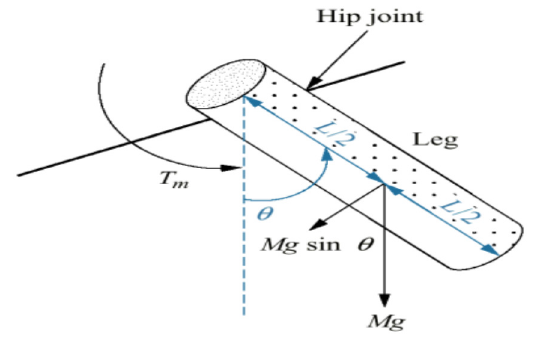
Fig. 1. Human a robotic leg cylindrical model [9].